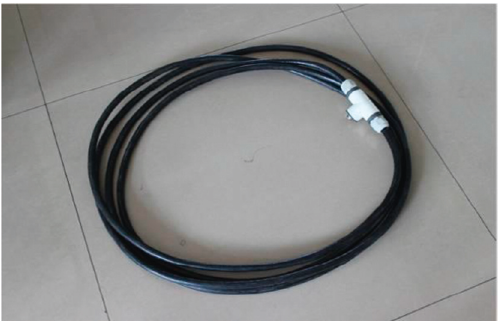
Figure 20: Launch wireframe.